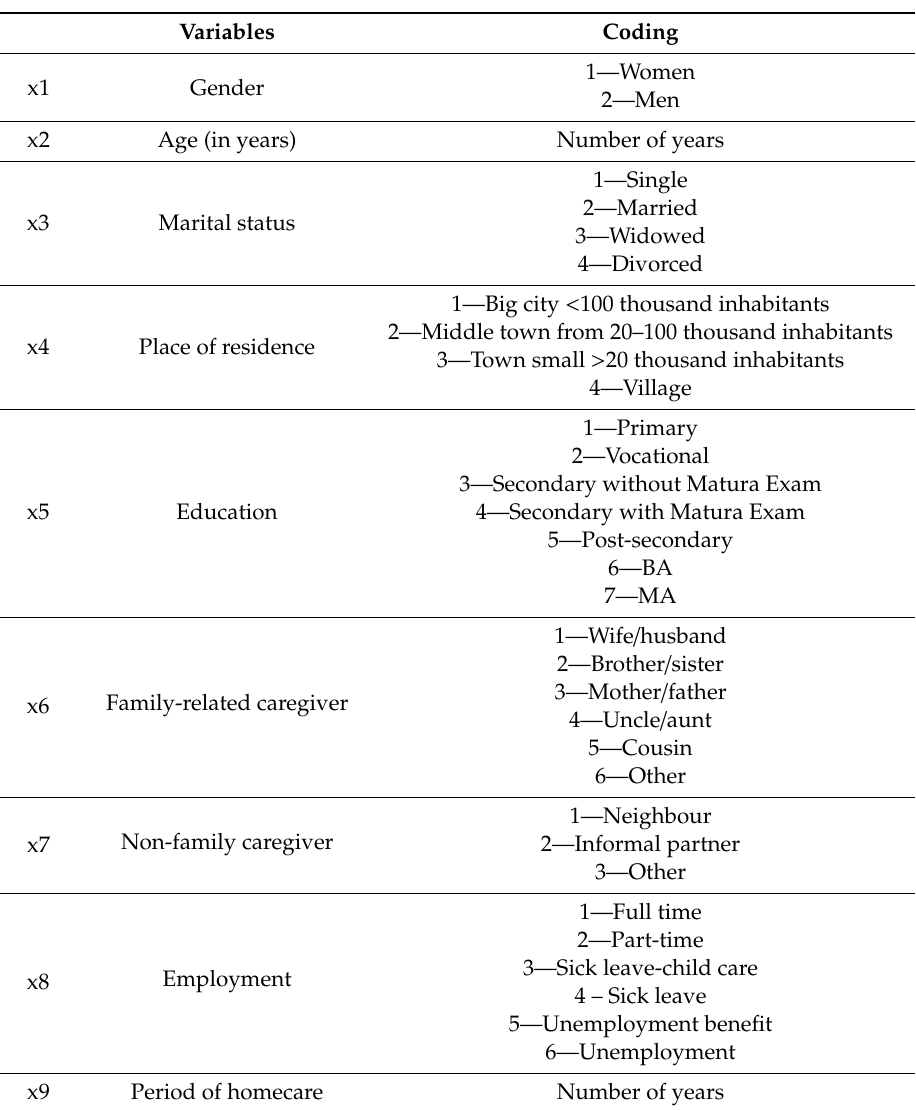
Table 1. Descriptive variables for logistic regression analysis